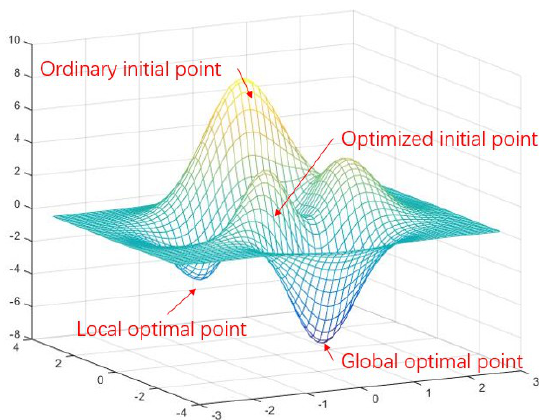
Figure 6. An illustration of association between initial point and result of optimization